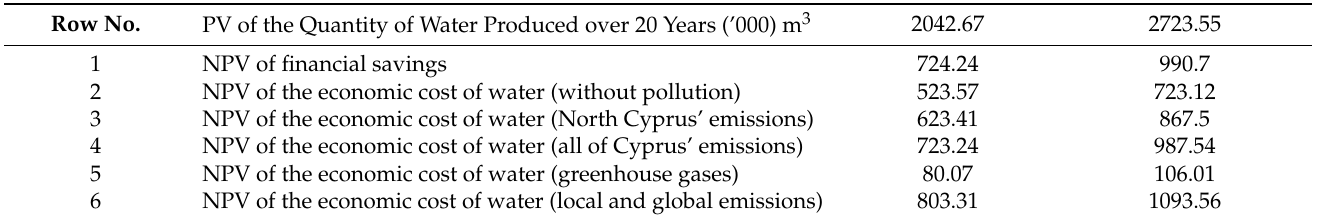
Table 15. The NPVs of investing into the new technology with 20 years of operation (in 2022 prices), (’000) USD.